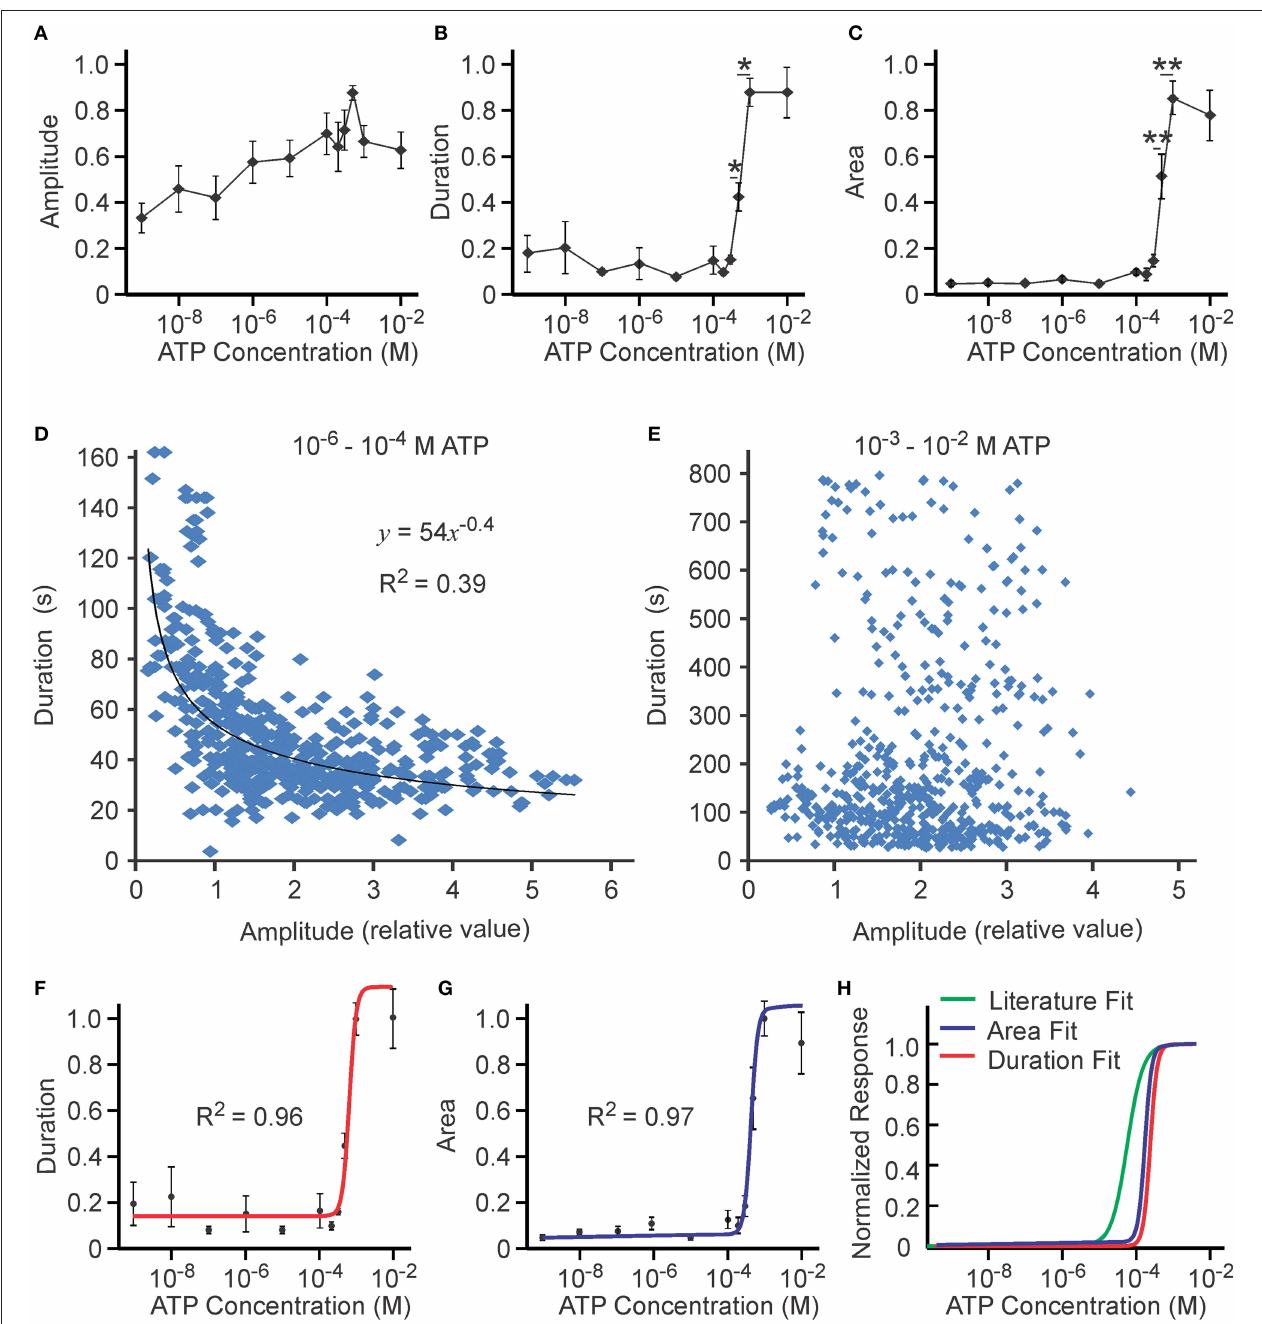
FIGURE 5 | Ca 2 + responses induced by high [ATP]. Changes in [Ca 2 + ] i induced by bath application of 10 − 9 –10 − 2 M ATP to MC3T3-E1 cells loaded with fluo-4 were analyzed. (A) [ATP] dependence of average peak amplitude. (B) [ATP] dependence of average response duration. (C) [ATP] dependence of average area under calcium response. For (A–C) data are means ± SEM, n = 8 independent experiments, 11–55 cells per condition in each experiment. Differences (indicated by horizontal lines) were analyzed by ANOVA and were significant for (B,C) , p < 0.0001 . Selected statistically significant differences are shown with asterisks that demonstrate significant increases with an increase in applied [ATP] assessed by Tukey post-test (* p < 0.05 , ** p < 0.01 ). (D,E) The correlation between the amplitude and duration of Ca 2 + responses was examined in 520 individual cells exposed to 10 − 6 –10 − 4 M ATP (D) and in 588 individual cells exposed to 10 − 3 –10 − 2 M ATP (E) . (F) The [ATP] dependence for the duration of calcium response was fit with the Hill equation with K 1 / 2 = (6.0 ± 0.6) × 10 − 4 M and h = 4 ± 1 and an offset of β = 0.13 ± 0.03. (G) The [ATP] dependence for the area under calcium response was fit with the Hill equation with K 1 / 2 = (4.6 ± 0.3) × 10 − 4 M and h = 4 ± 1 with an offset of β = 0.05 ± 0.02. (H) Comparison of published P2X7 fit (green line) obtained for the overexpressed receptor [ K 1 / 2 = (1.3 ± 0.3) × 10 − 4 M and h = 2.2 ± 0.8; (Surprenant et al., 1996)] to the fits for average duration (red line, same as in F ) and average area (blue line, same as in G ) observed in our experimental data.